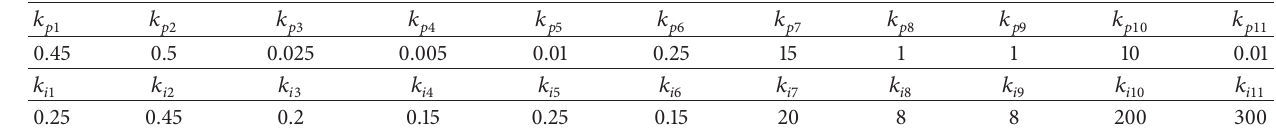
Figure 7: The combined small signal model for whole system. Table 1: Controller parameters.